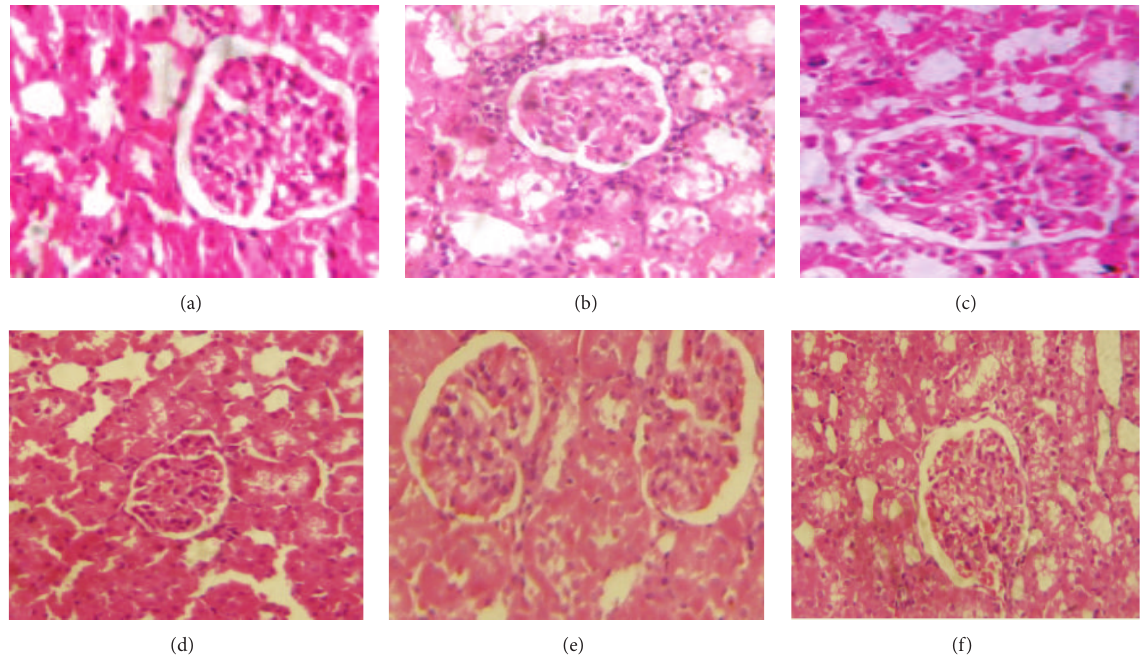
Figure 1: Photomicrographs of renal cortex of (a), (b), and (c), control, DLD, and DHD groups, respectively, showing normal lobular organization of the renal cortex; normal renal glomeruli and tubules. (d) DOX treated group showing markedly enlarged and congested vascular renal glomeruli and cytoplasmic vacuolations of corpuscular cells. Inflammatory cell infiltrations are observed. (e) DOX/DLD group showing less cytoplasmic vacuolations of the renal corpuscular cells and tubular cells. (f) DOX/DHD showing apparent normal renal cortex. H&E × 400. Bar = 20 𝜇 . Table 3: Scoring of morphological changes observed in control and experimental groups by light microscope ( 𝑛 = 6 ). Findings